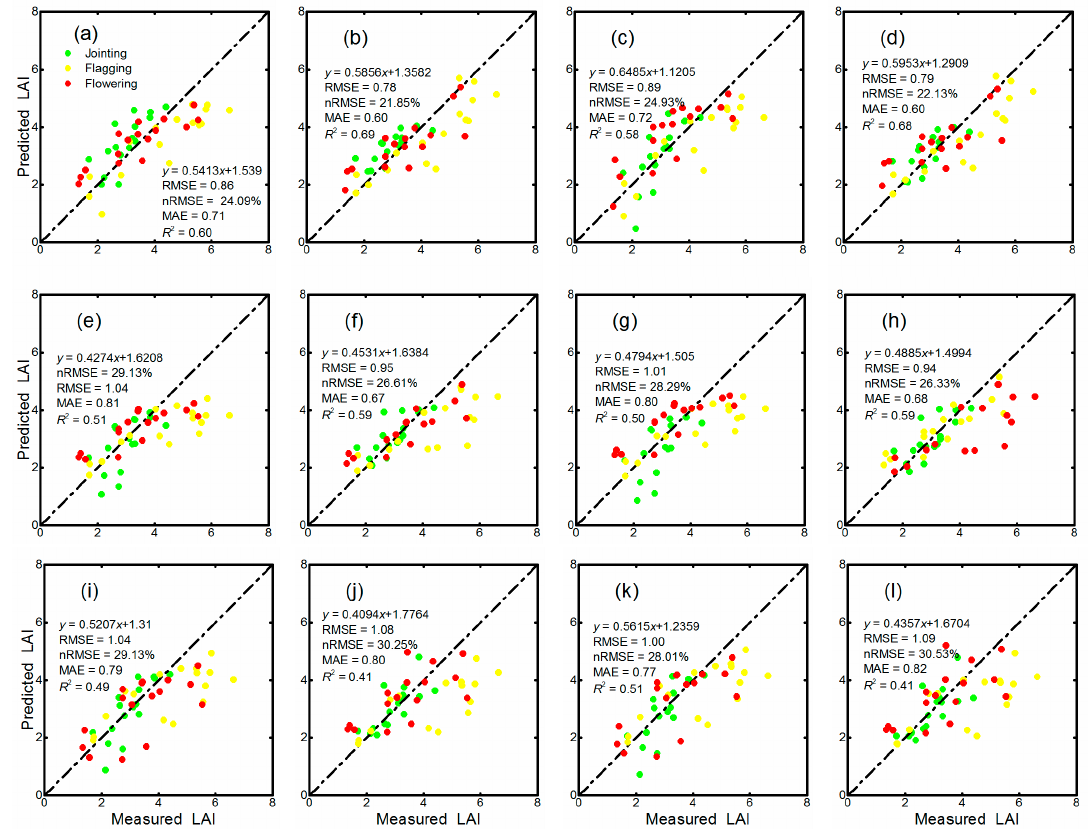
Figure 9. Relationship between predicted and measured winter wheat LAI (m 2 /m 2 ): ( a ) G-height, VIs, and PLSR; ( b ) G-height, VIs, and RF; ( c ) G-VIs and PLSR; ( d ) G-VIs and RF; ( e ) UHD-height, VIs, and PLSR; ( f ) UHD-height, VIs, and RF; ( g ) UHD-VIs and PLSR; ( h ) UHD-VIs and RF; ( i ) DC-height, VIs, and PLSR; ( j ) DC-height, VIs, and RF; ( k ) DC-VIs and PLSR; ( l ) DC-VIs and RF (validation dataset, mean LAI = 3.57 m 2 /m 2 ).